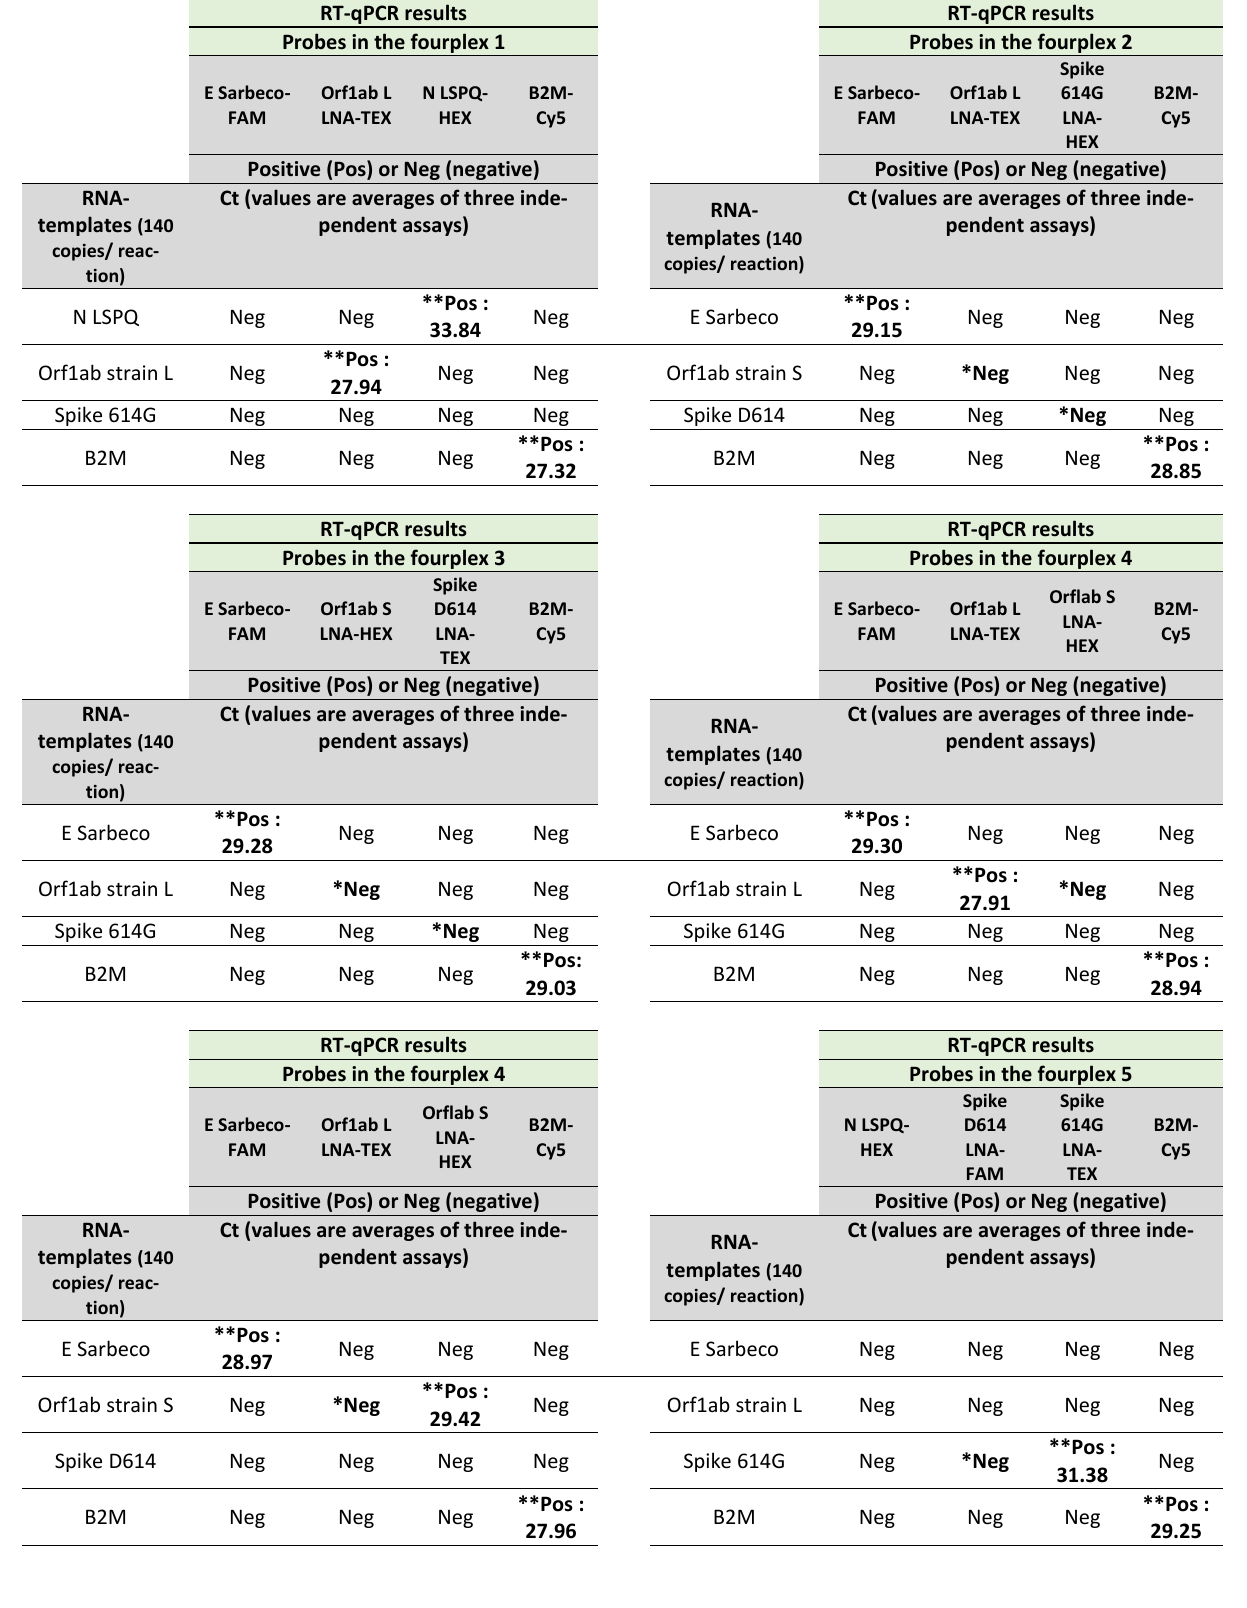
TABLE 5. Real-time genotyping with oligonucleotide probes containing locked nucleic acids (LNA) for detection of SARS-CoV-2 vari-